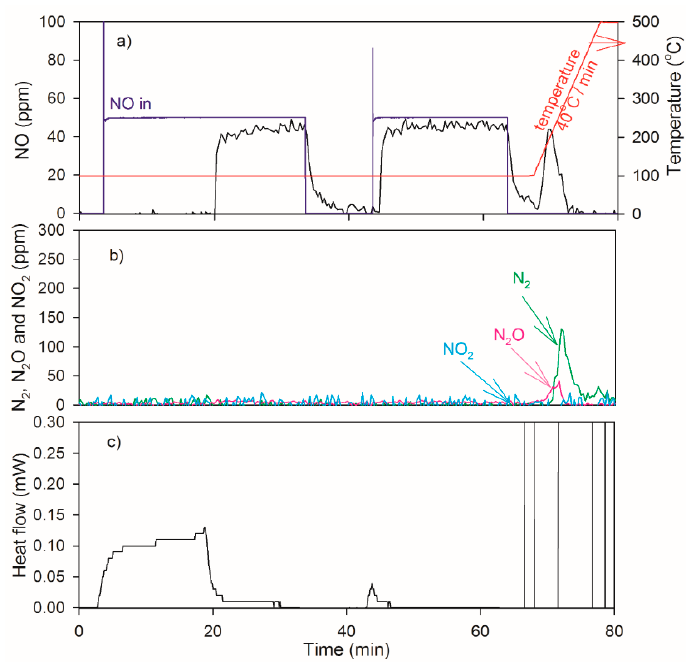
Figure 1. ( a ). NO concentration and temperature as function of the time, ( b ) resulting N 2 , NO 2 , and N 2 O concentrations, ( c ) corresponding heat flow during NO TPD at 100 °C for 2 wt. % Pt/Al 2 O 3 . Experimental details are described in Section 3.